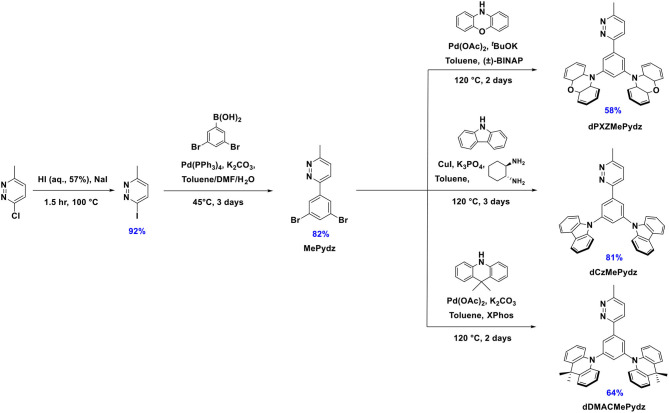
Synthetic scheme of pyridazine-based emitters.